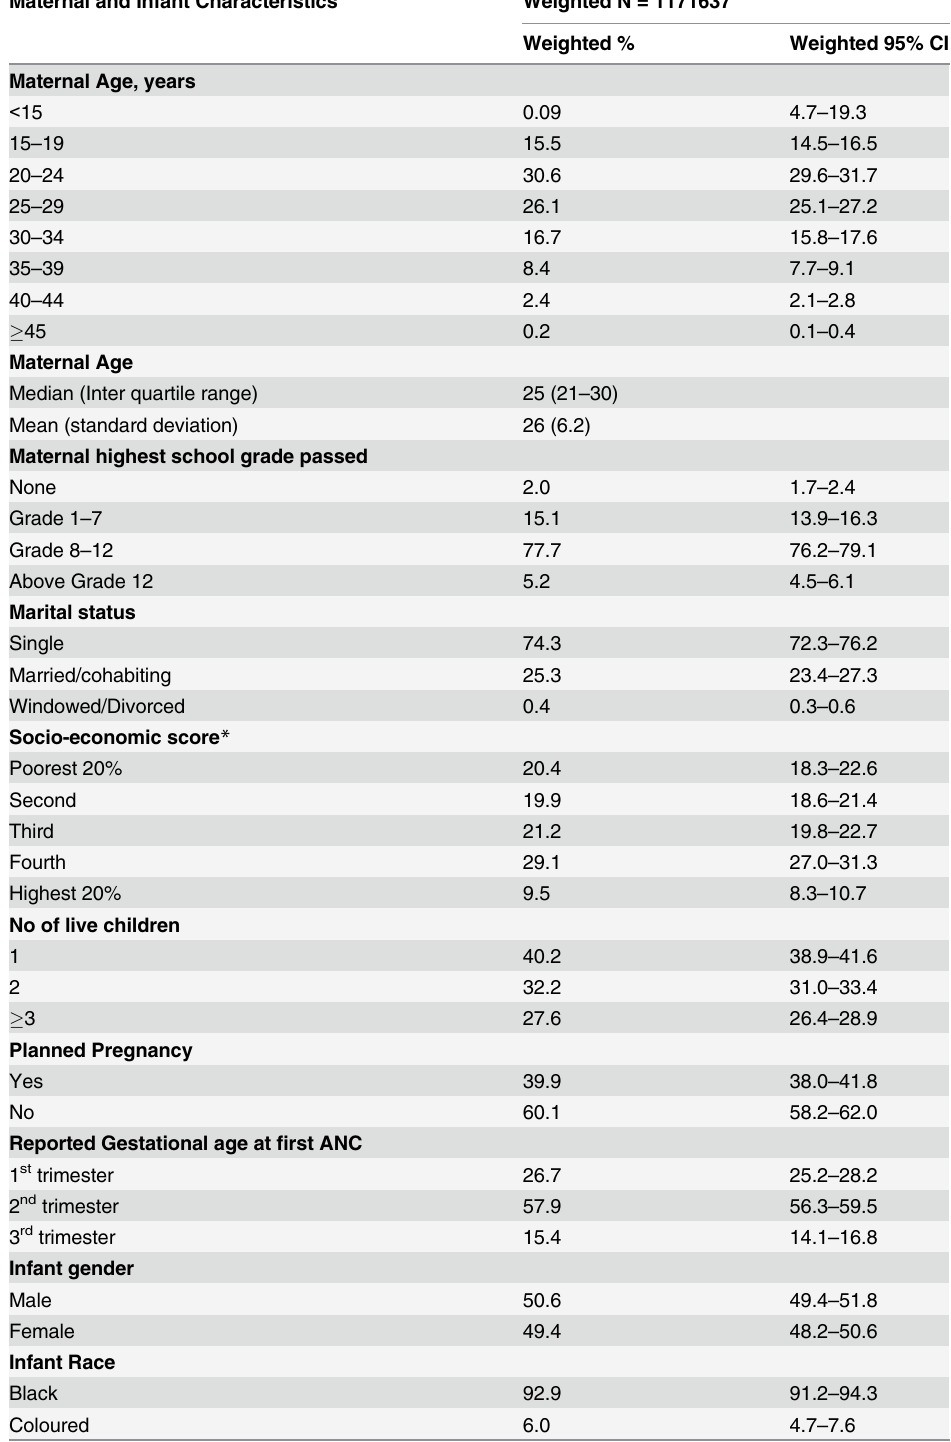
Table 1. Characteristics of mother-infant pairs in the 2010 PMTCT cascade